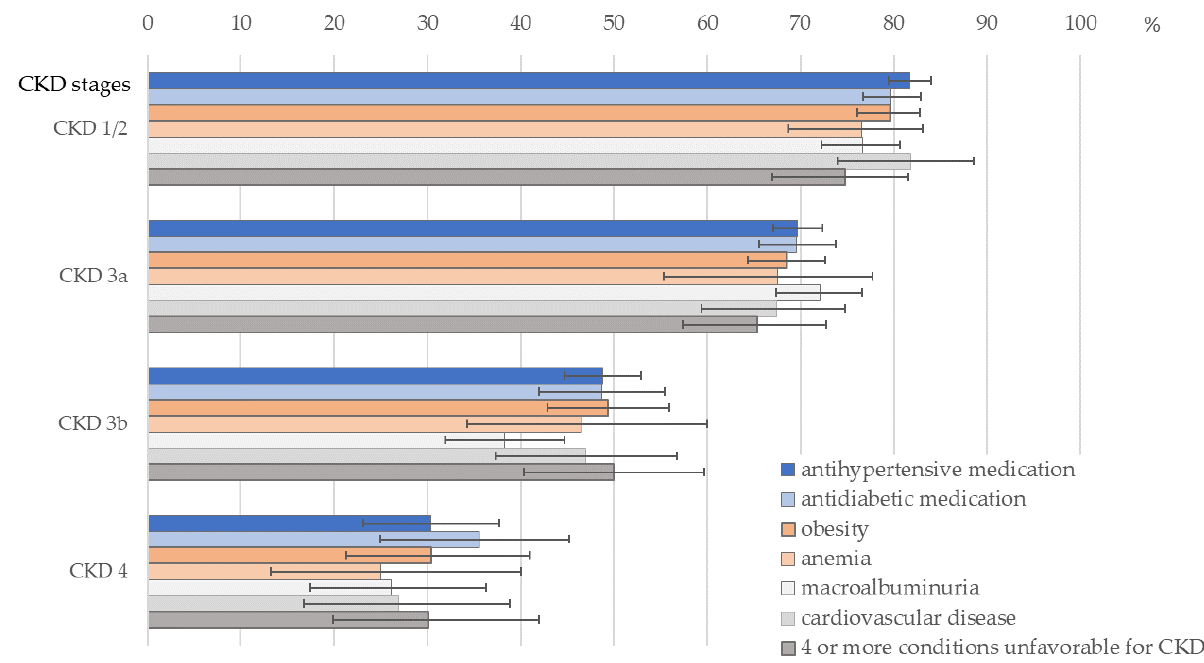
Figure 4. Prevalence and 95%-CI of unawareness in CKD Stages 1 or 2, 3a, 3b and 4 in subgroups of patients—conditions unfavorable for CKD: macroalbuminuria (ACR ≥ 300 mg/g), antihypertensive medication, antidiabetic medication, anemia, obesity (BMI ≥ 30 kg/m 2 ), history of cardiovascular disease, current smoking, age < 70 years. More data are provided in Supplementary Table S1.